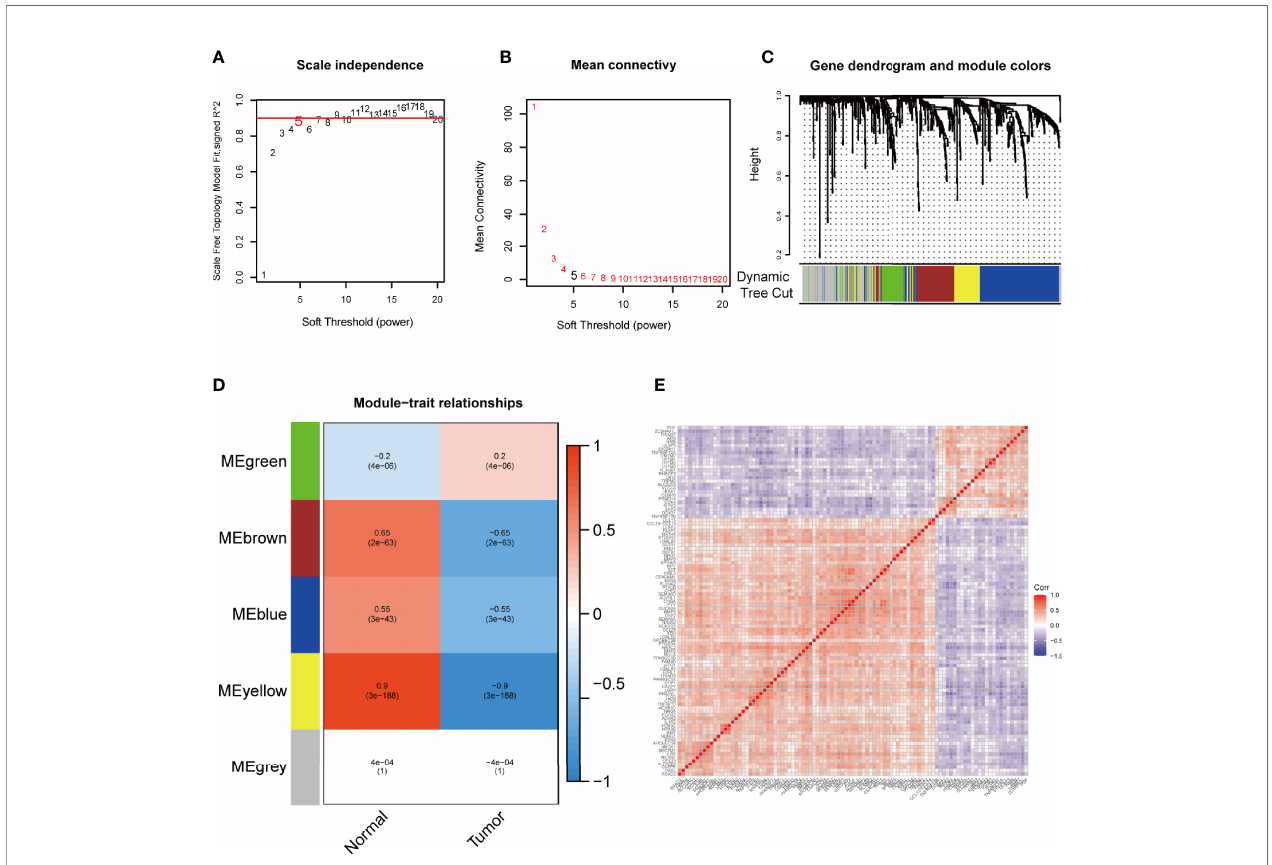
FIGURE 3 | WGCNA to mine differential immune gene modules. Analysis of IRGPI-related gene modules by WGCNA. (A) Analysis of the scale-independence of various soft-thresholding powers. (B) Mean connectivity analysis of various soft-thresholding powers. (C) Identi fi cation of co-expression modules. The branches of the tree diagram correspond to the fi ve different gene modules. (D) Correlation of gene modules with tumor microenvironment correlation scores. Each cell contains the corresponding correlation coef fi cient and P -value. (E) Correlation analysis of each gene in the yellow module. WGCNA, weighted gene co-expression network analysis and IRGPI, immune-related gene prognostic